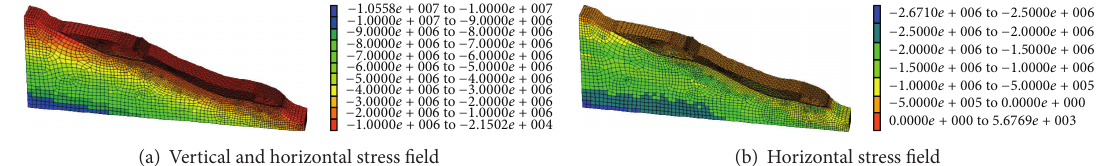
Figure 10: Initial stress field nephogram of the slope under natural state.